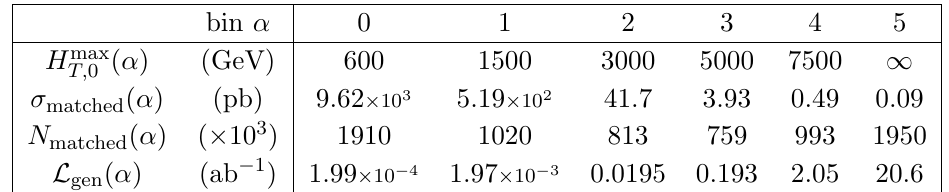
Table 10. The upper edge value of H T; 0 , the leading-order matched cross section, the number of samples after matching, and equivalent luminosity in each H T; 0 bin for the Z -boson production process.